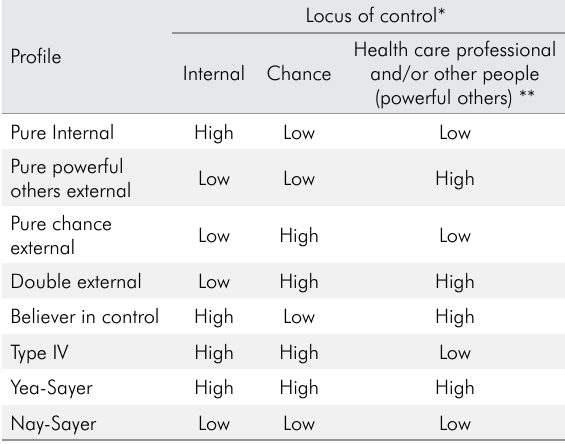
Table 1. Locus of control profiles according to the system suggested by Wallston and Wallston